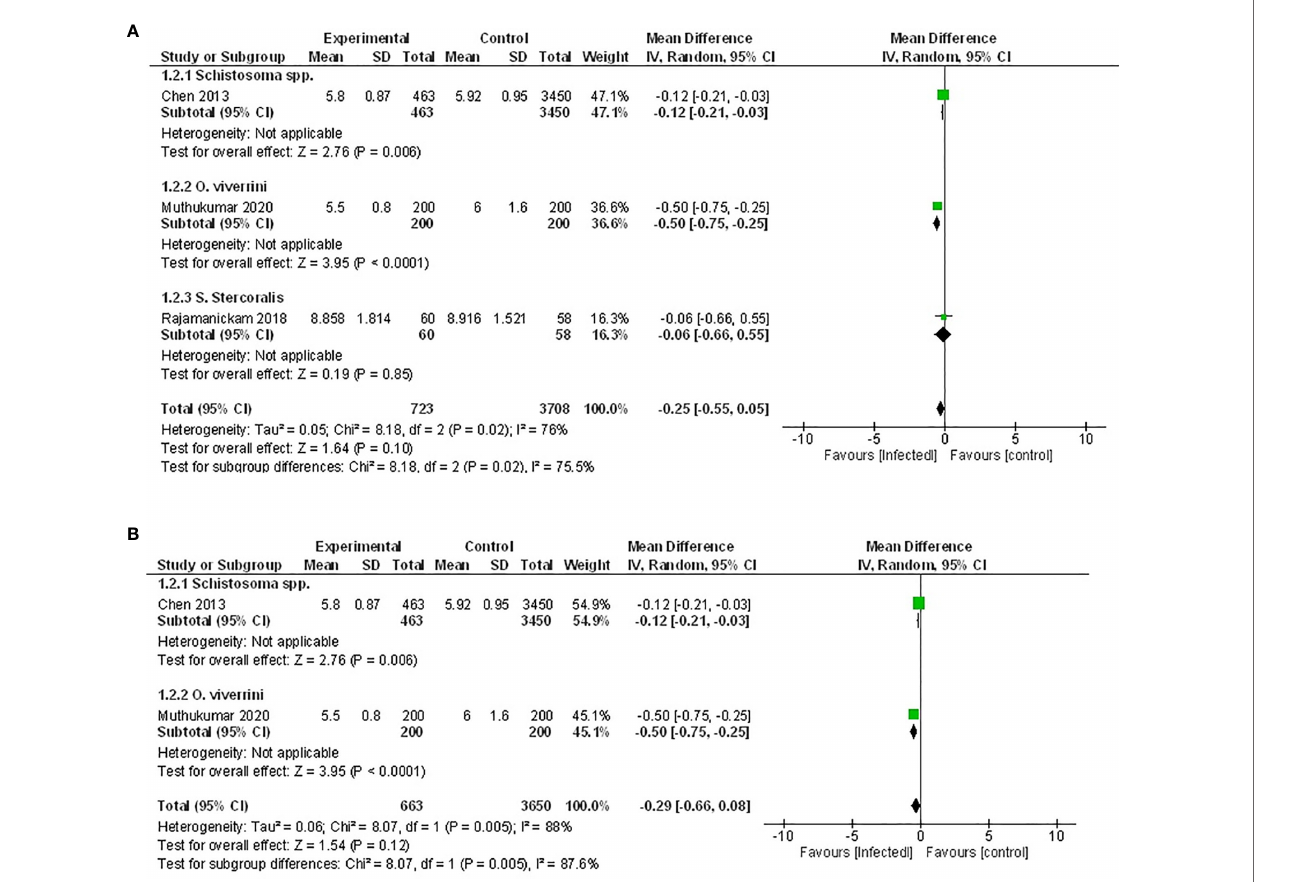
Frontiers in Endocrinology |